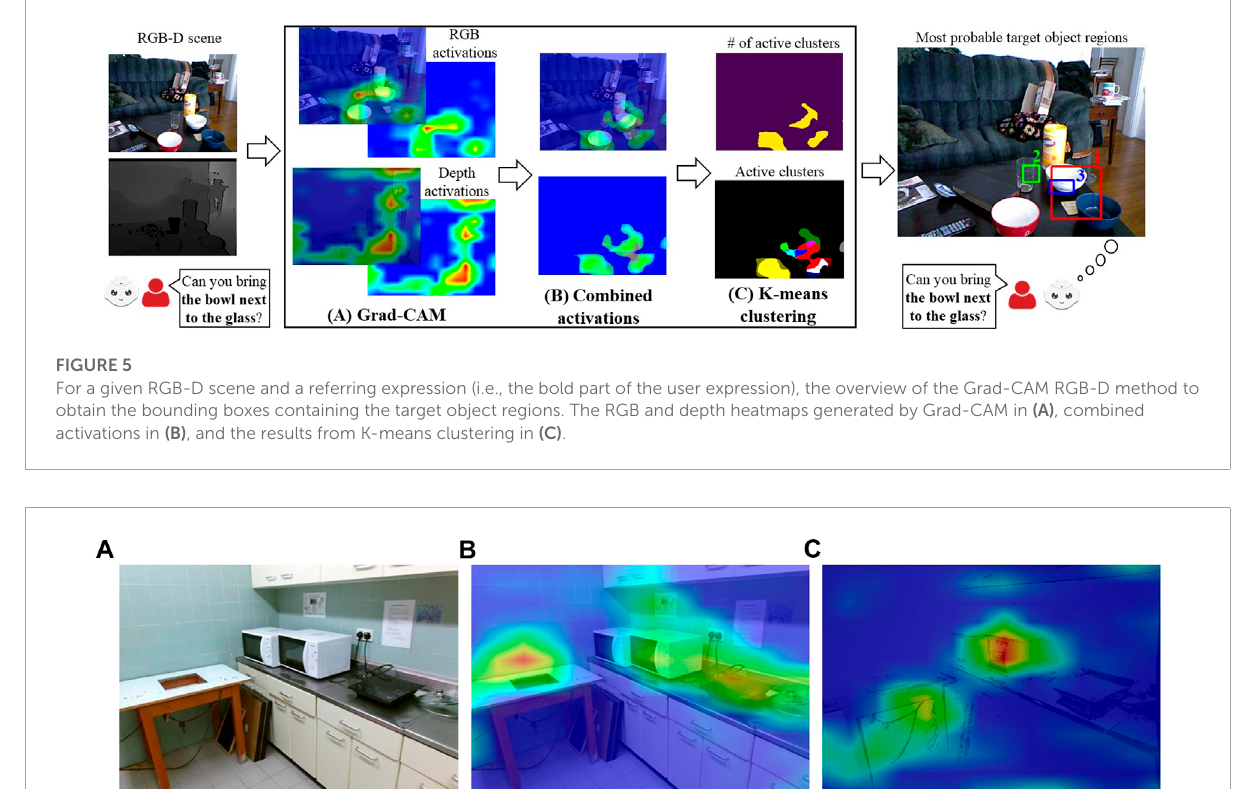
explained in Section 3.1.2.1 – see the first row of Figure